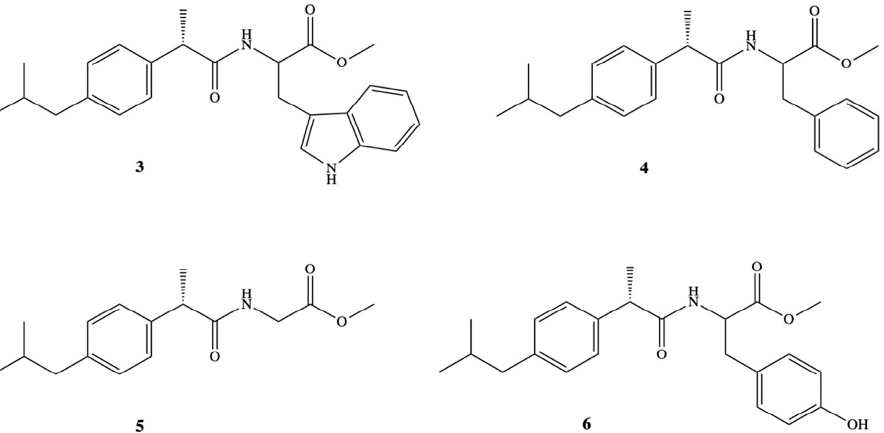
Figure 4. Amide prodrugs of dexibuprofen with L -tryptophan, L -phenylalanine, glycine, and L - tyrosine.